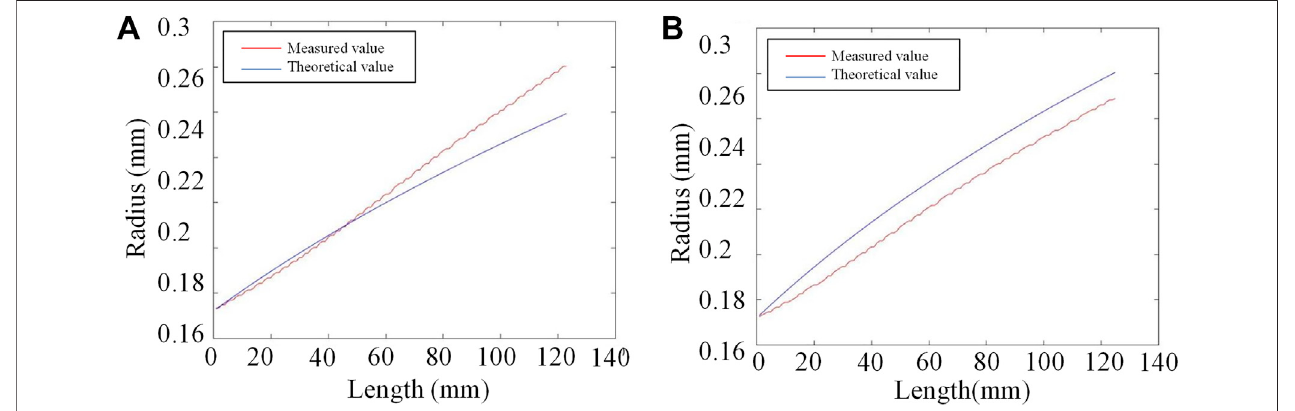
FIGURE 11 | Two main kinds of deformation of the condenser resulting in an imperfect far- fi eld pattern. Simulated (left part) and measured (right part) distorted output facula of the condenser caused by elliptic deformation (A) and center line deviation (B) of the condenser (simulated fi gure cited from Ref. [23]).